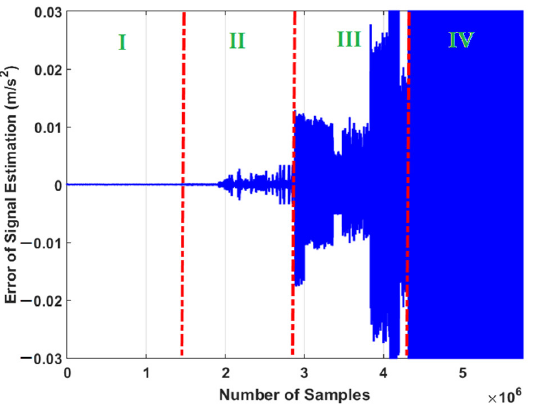
Figure 5. Error of signal estimation using proposed ADT algorithm: (I) NC, (II) RF, (III) IF, and (IV) OF.